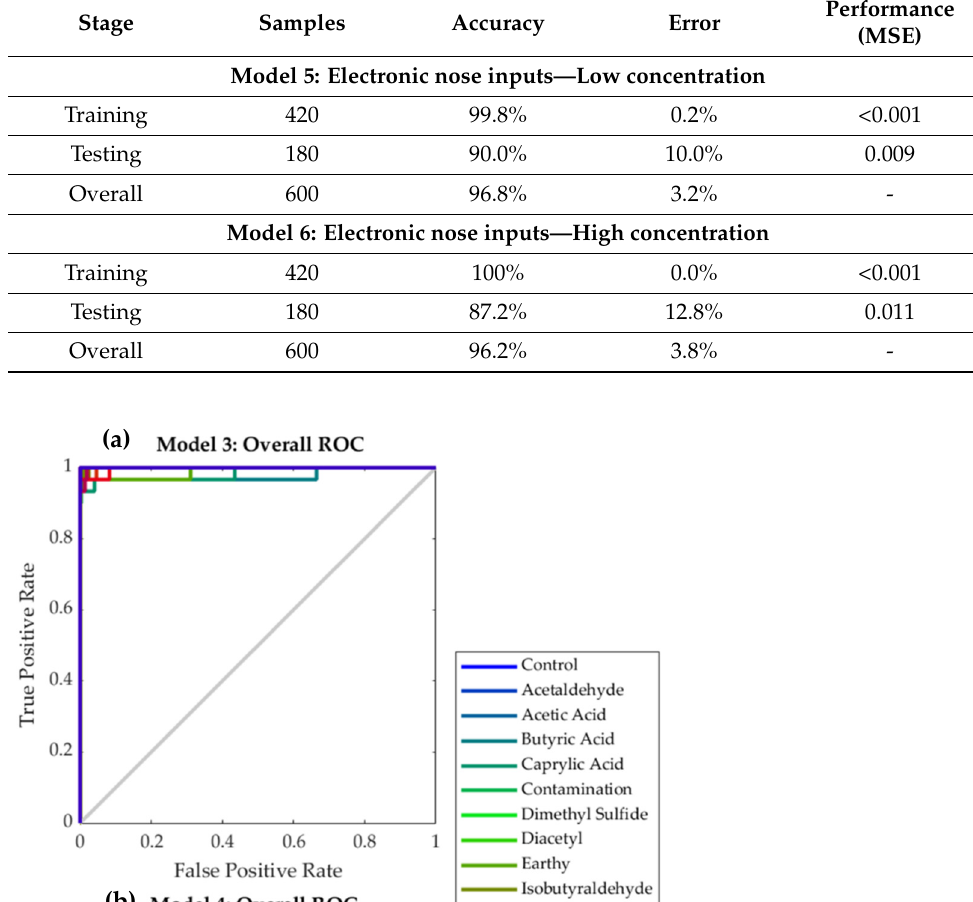
Table 5. Statistical results of the artificial neural network classification models developed using the electronic nose outputs as inputs. Abbreviations: MSE: means squared error.